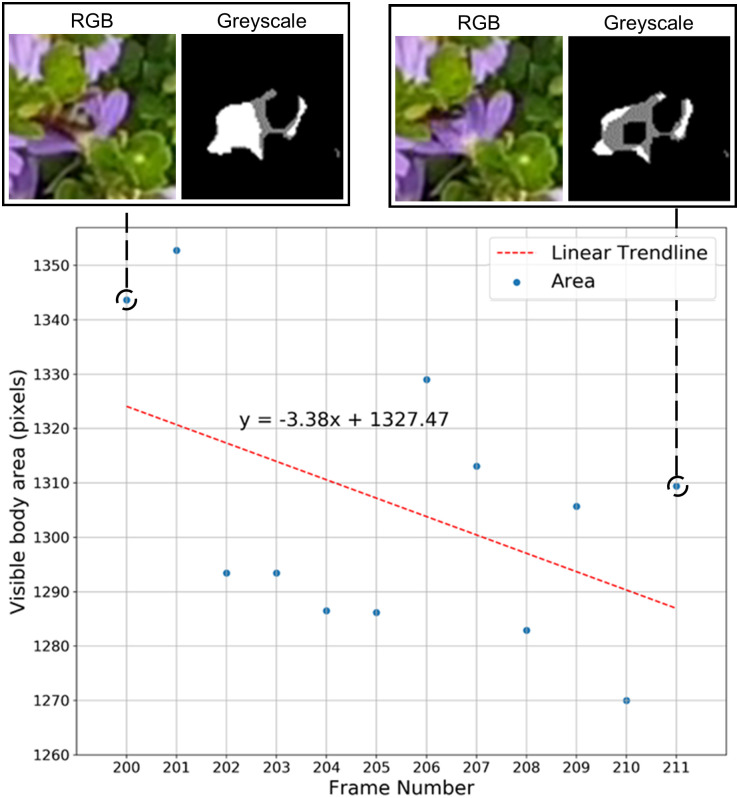
An example of an insect occluded under foliage.Scatterplot shows the variation of insect visible body area before occlusion, and the corresponding least squares polynomial fit. Pixel intensity in the greyscale image represents the amount of change detected in the foreground.